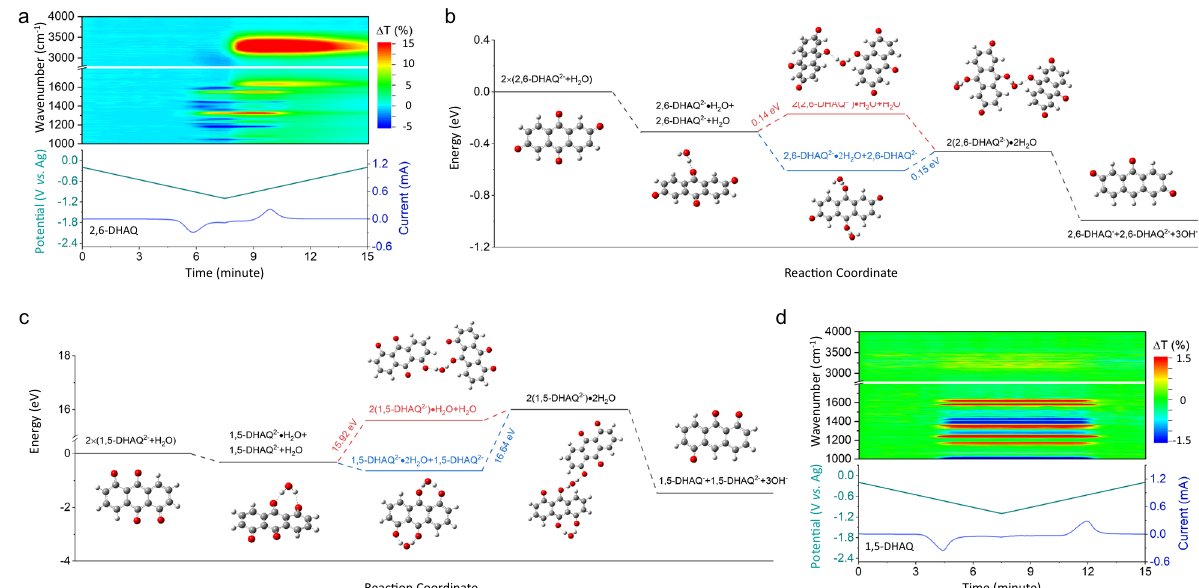
Fig. 1 | Degradation analysis of DHAQs. a Evolution of the operando FTIR spectra of 2,6-DHAQ during reduction and oxidation processes in the fi rst cycle ofCVscan. b , c Thecalculatedenergychangesof2,6-DHAQ( b )and1,5-DHAQ( c ) and water at different redox states. Inserts shows the corresponding optimized structures. d Evolution of the operando FTIR spectra of 1,5-DHAQ during